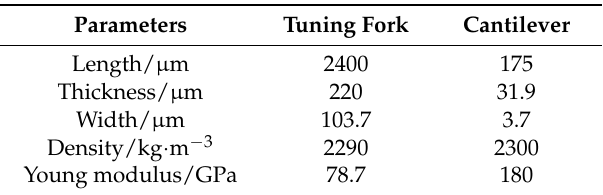
Table 2. The parameters of ANSYS simulation.